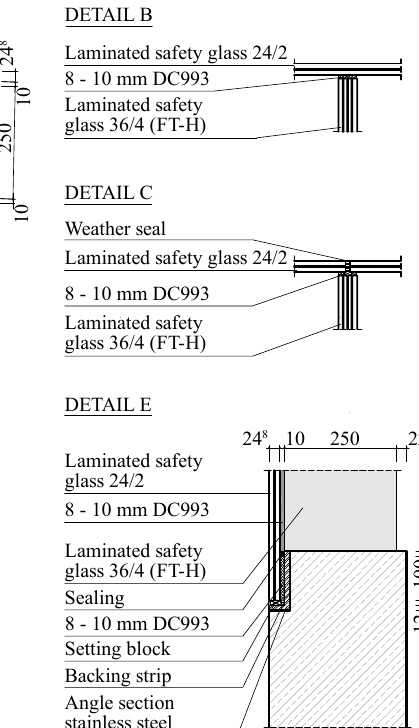
Figure 2: Details - frame corner (A), connection of vertical glazing and frame (B), connection of horizontal glazing and frame (C), base mount (D), connection of vertical glazing and concrete trough